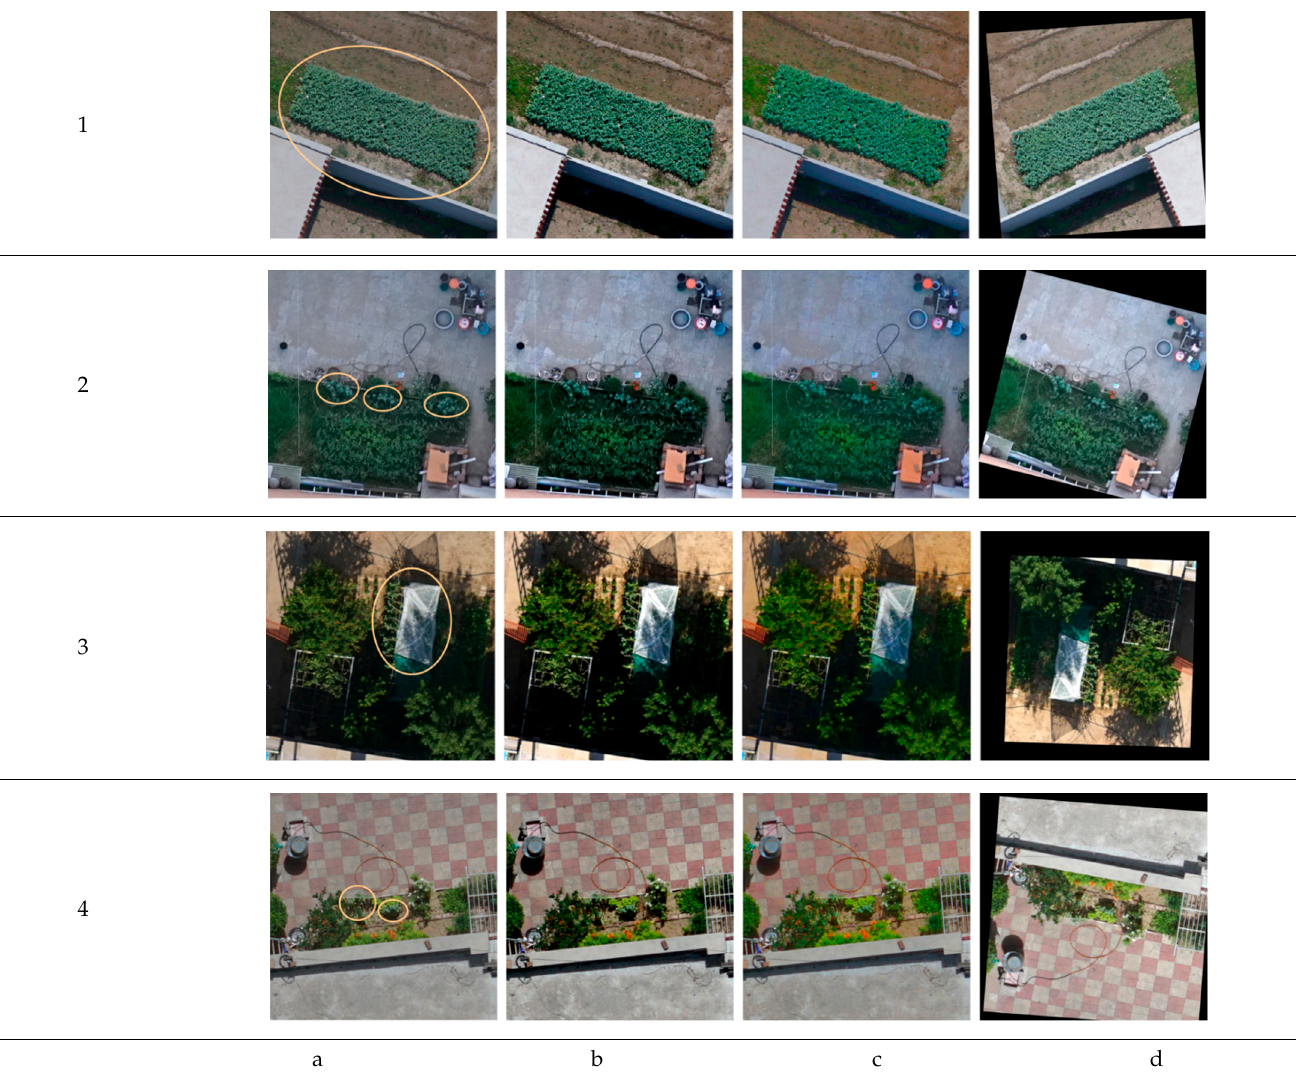
Table 2. Examples of preprocessed Papaver somniferum images for different planting strategies.